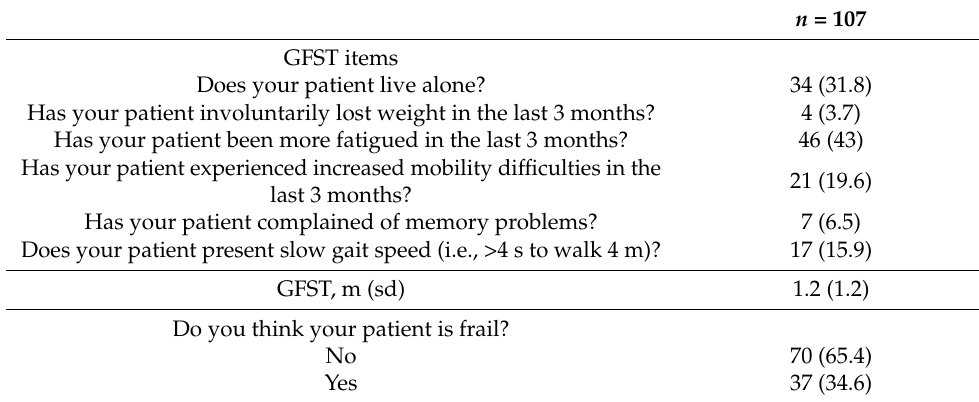
Table 3. Frailty measured by GFST scale.